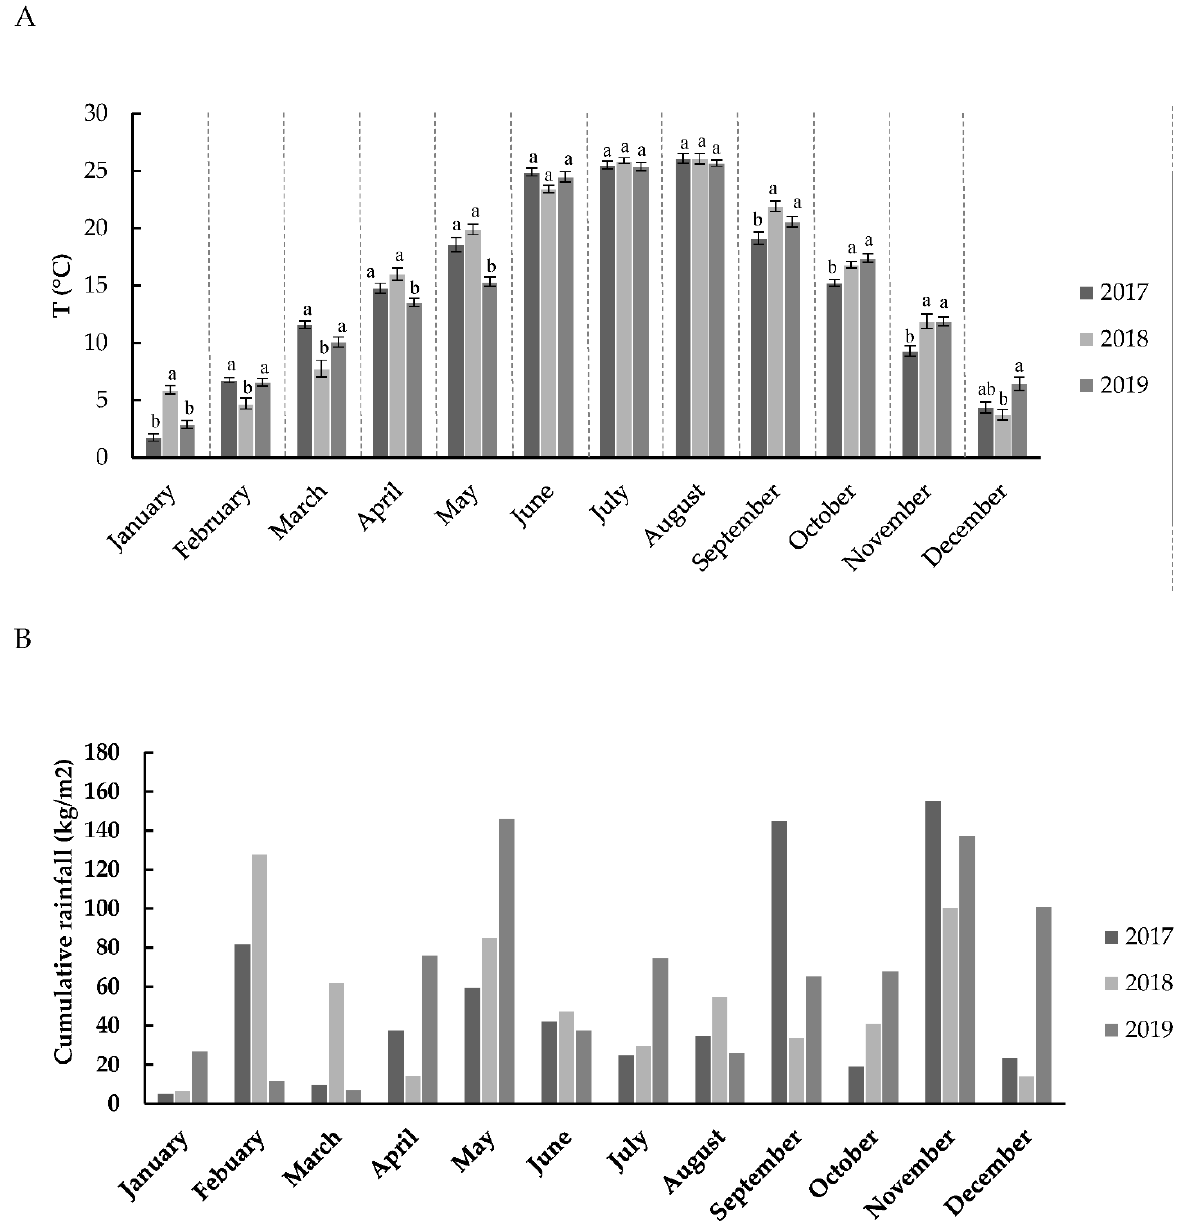
Figure 1. Average monthly temperatures ( A ) and cumulative rainfall ( B ) recorded for the tomato and durum wheat farms in the region of Fiscaglia, Ferrara (Emilia Romagna, Italy) between 2017 and 2019. Different letters indicate significant differences ( p < 0.05).